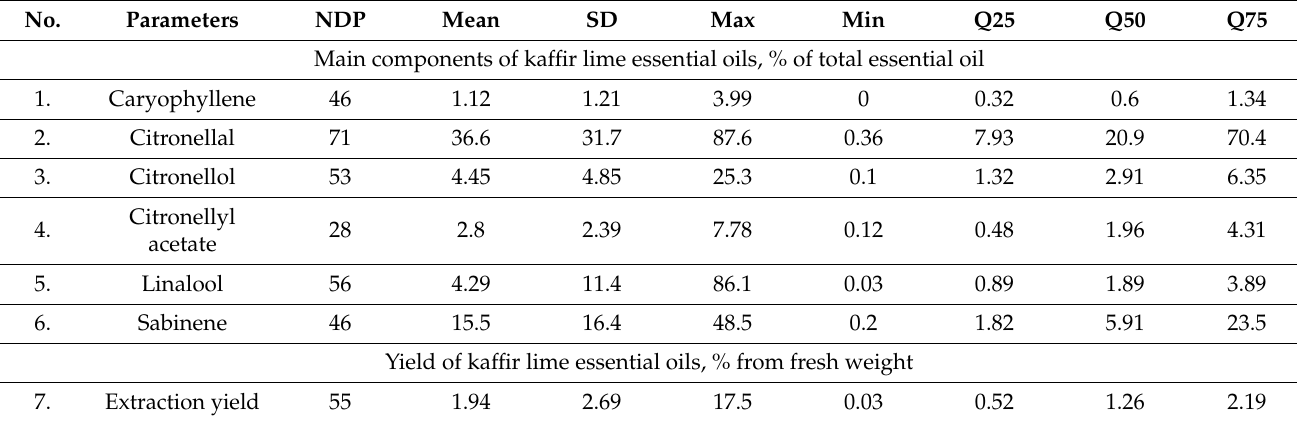
Table 2. Data aggregation and descriptive statistics of tabulated database.